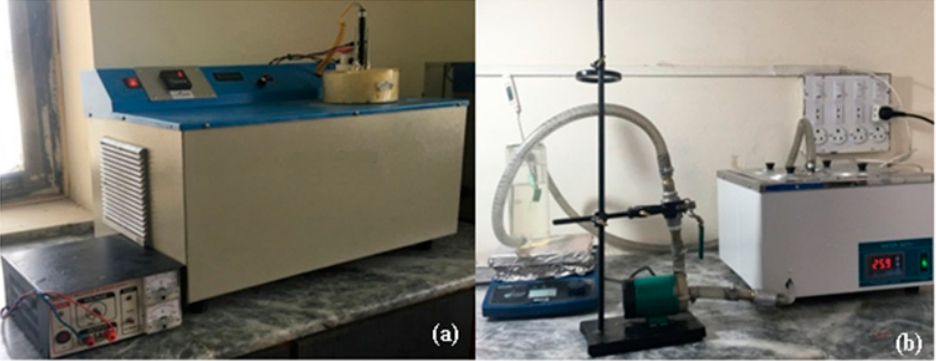
Figure 9. Self-designed setups ( a ) anodization ( b ) chemical bath deposition.